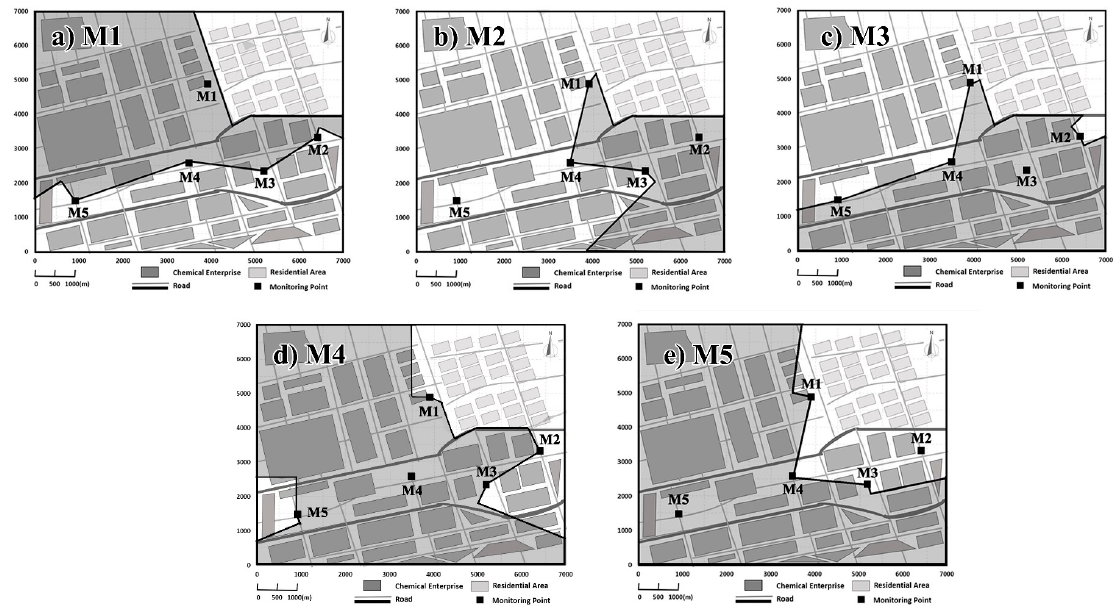
Figure 5. The smallest representative regions for M1–M5: ( a ) the smallest representative regions of M1; ( b ) the smallest representative regions of M2; ( c ) the smallest representative regions of M3; ( d ) the smallest representative regions of M4; ( e ) the smallest representative regions of M5.